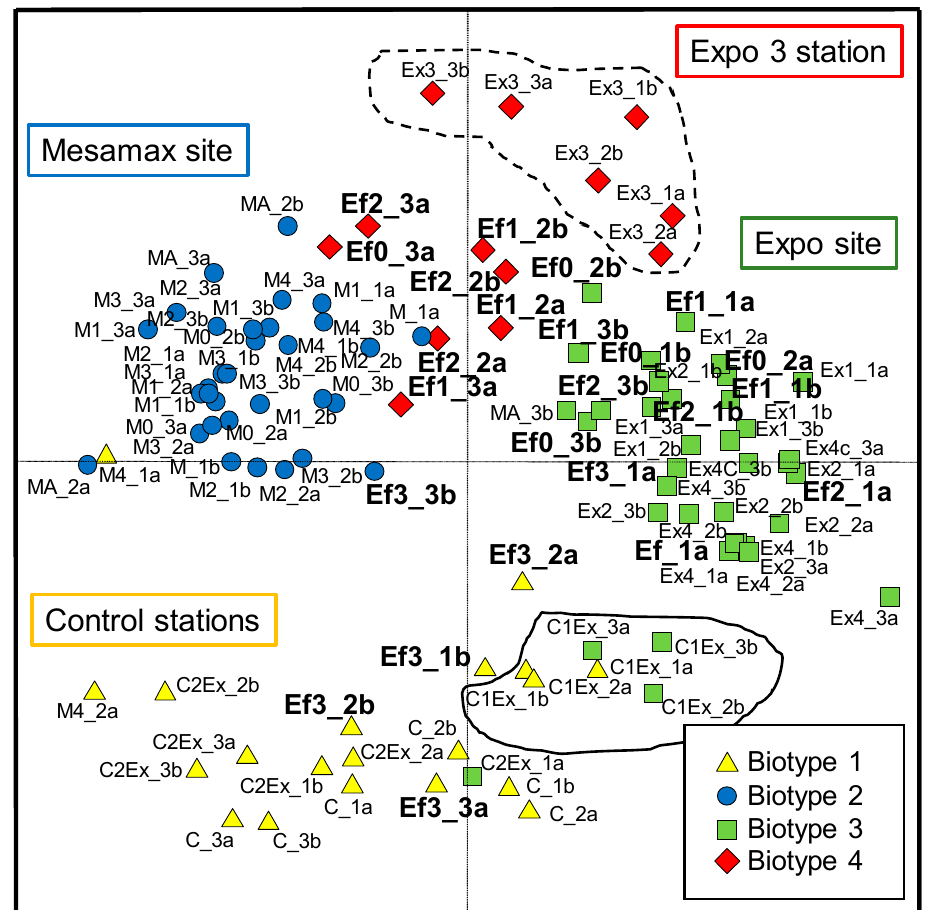
Figure 2. Principal Component Analyses (axes 1 and 2) showing station distribution based on diatom assemblages collected in July (a) and August (b) of 2014–2016 (1 = 2014, 2 = 2015, 3 = 2016). Samples are color-coded according to the biotype they belong to. The dashed line groups the samples from Ex3 where all six diatom assemblages collected belong to biotype 4. The solid line groups the samples from the control station C1Ex where diatom assemblages belong to biotypes 1 and 3 depending on the sampling date. Samples in bold showed variability in diatom assemblages throughout the study.